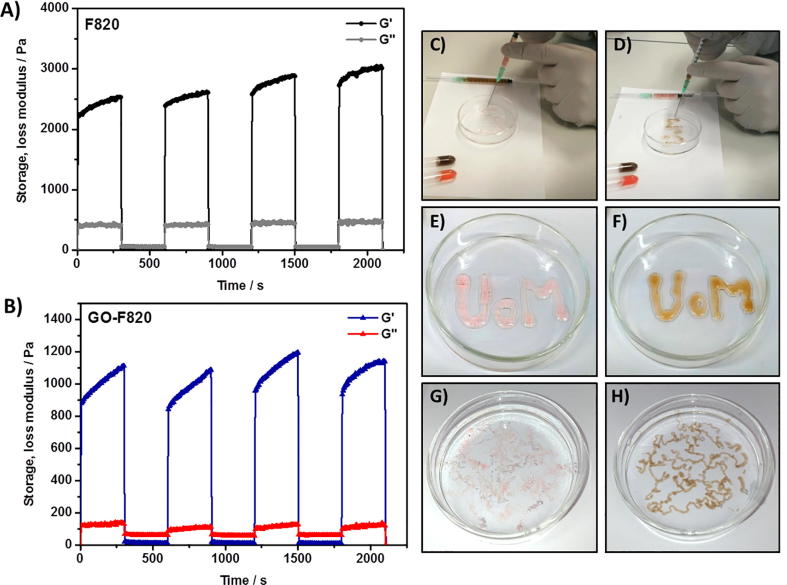
Left: Shear-thinning and recovery experiments demonstrating hydrogels’ injectability (Top: F820 formulated without GO; Bottom: GO-F820 formulated with GO). Right: Photographs of hydrogels being injected in a Petri dish (C & E: Hydrogel formulated without GO; D & F: Hydrogels formulated with GO) and in PBS (G: hydrogel formulated without GO; H: Hydrogel formulated with GO) (Pink dye was added to the hydrogels formulated without GO to enhance contrast). (For interpretation of the references to colour in this figure legend, the reader is referred to the web version of this article.)